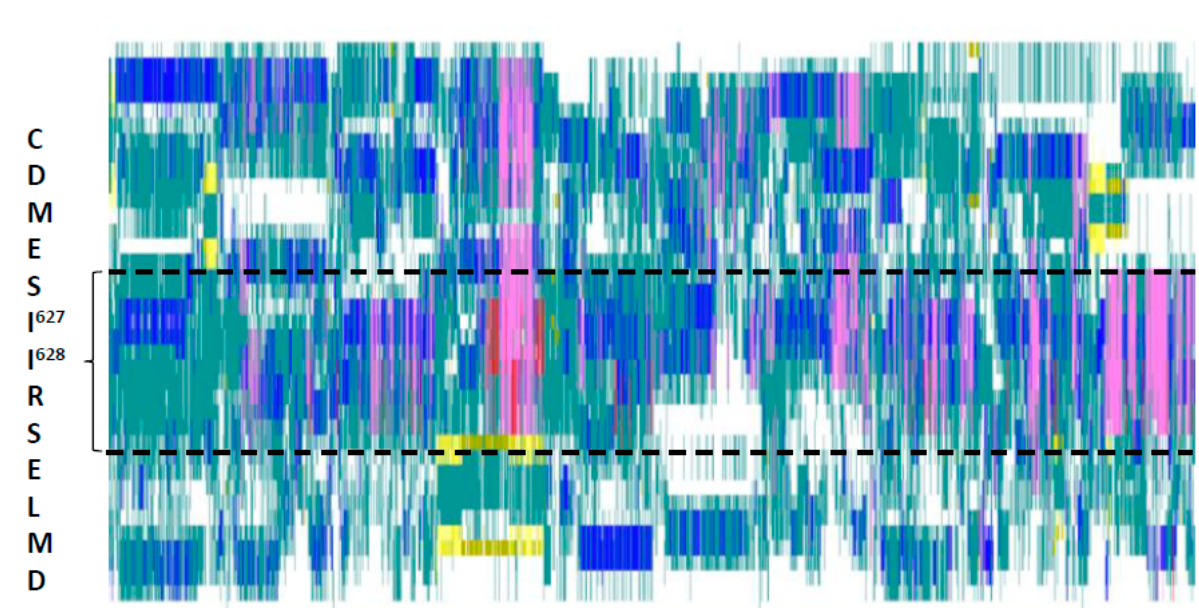
Figure 7. Secondary structures of the KIX-Binding Region and Transactivation Domain (TAD) formed in ten implicit solvation simulations (gb8_md#1—gb8_md#10), each representing 500 nanoseconds. The positions and sequences of α -helical regions shown are based on experimentally determined locations of KIX-binding motifs [17]. ( A ) The region (residues 451 to 500) surrounding the α -helix participating in binding to the KIX-domain of the CBP/p300 coactivator complex is shown. The position and sequence of the interaction helix (FOXO 467 − 478 ) binding to the KIX domain directly is highlighted. ( B ) The region (residues 606 to 644) surrounding another α -helix participating in binding to the KIX-domain of the CBP/p300 coactivator complex is shown. The position and sequence of the interaction helix (FOXO 622 − 634 ) binding to the KIX domain directly is highlighted. The color codes represent the secondary structures formed in each simulation frame at each position of the primary amino acid sequence (pink, α -helix; dark blue, π -helix; red, 3 10 helix; yellow, extended conformation; cyan, turn; white, coil). Data visualized with VMD [34].